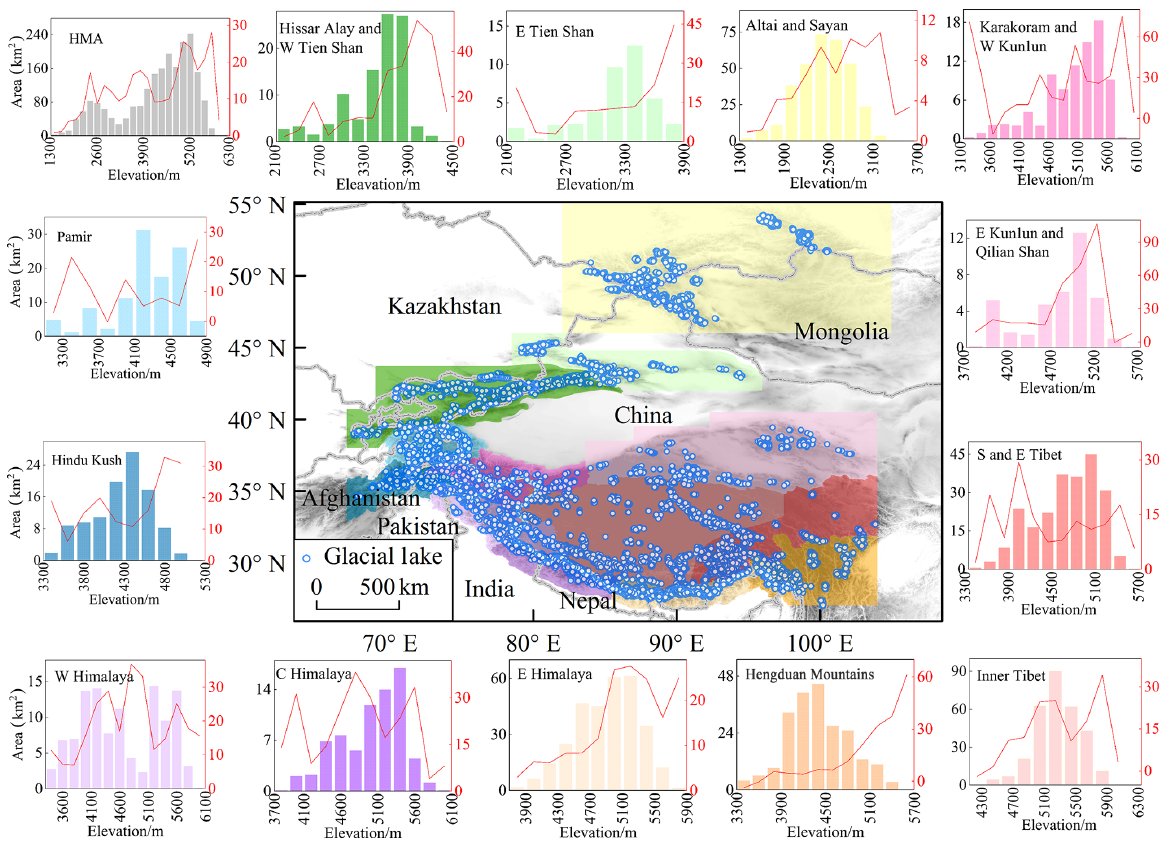
Figure 7. Distribution of and change in glacial lake area in the entire HMA and its 13 subregions from 1990 to